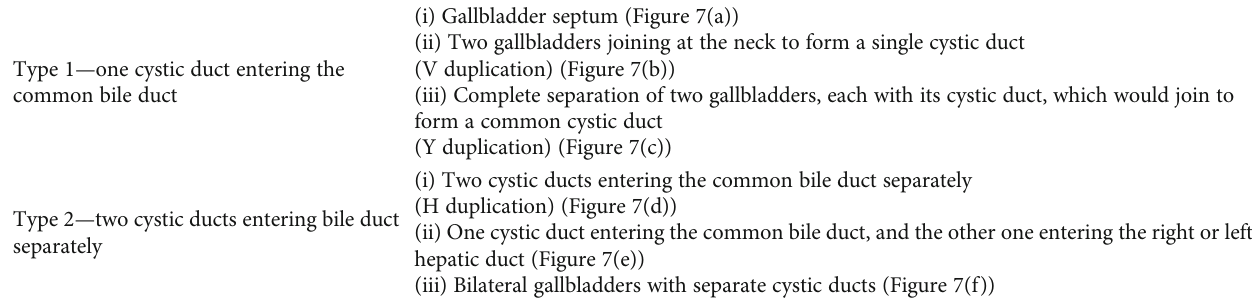
Table 1: Classi fi cation of duplication of the gallbladder (Figure 7) [4, 5].